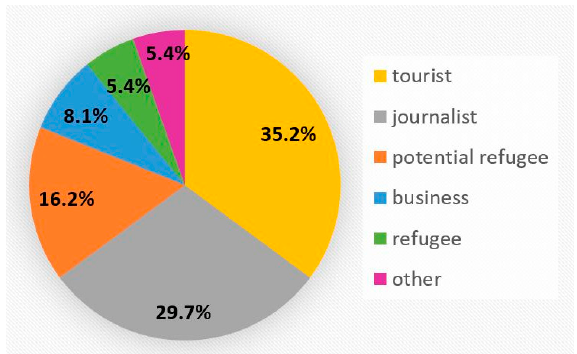
Figure 6. User groups identified through manual content